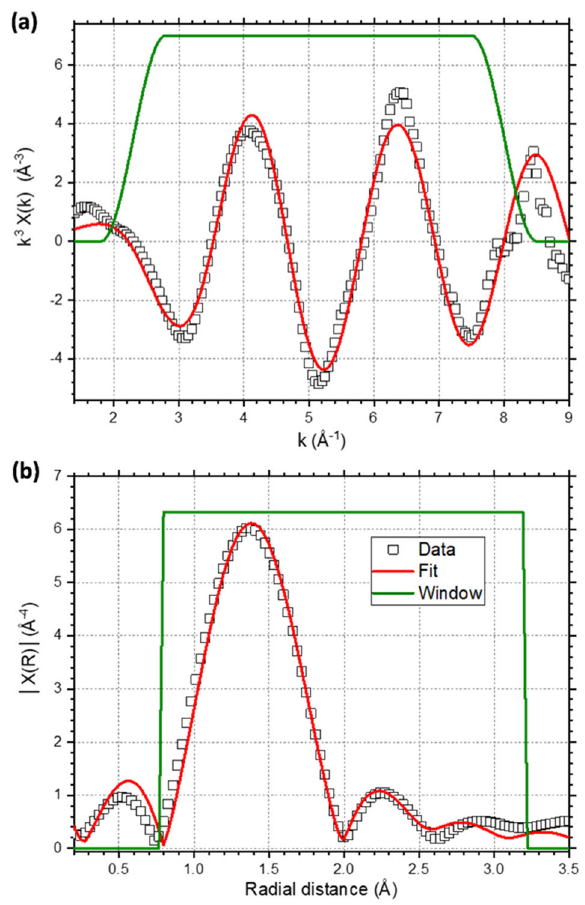
Fig. 4 EXAFS study of Cu-N-rGO sample. a k 3 -weighted Cu K edge EXAFS, b corresponding Fourier transform in R -space. The solid red lines represent the best fi t obtained using the structure of Fig. 3f. Table 1. EXAFS fi tting a parameters for structure (f).